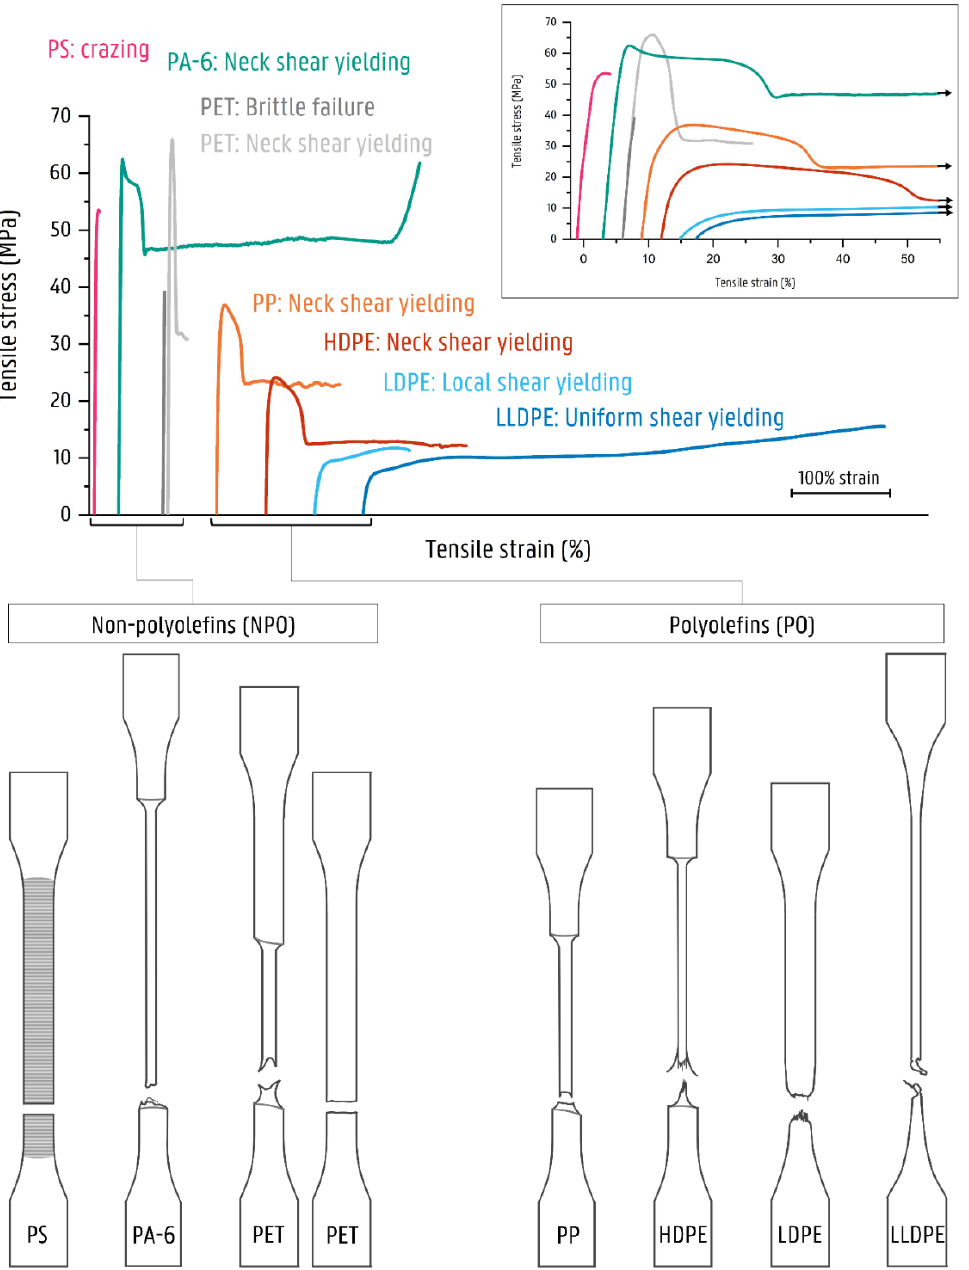
Figure 3. Stress–strain curves for the used mono materials and corresponding deformation mecha- nism. Crazing is indicated as fine mark lines for the neat PS. The exact values for ε b can be found in